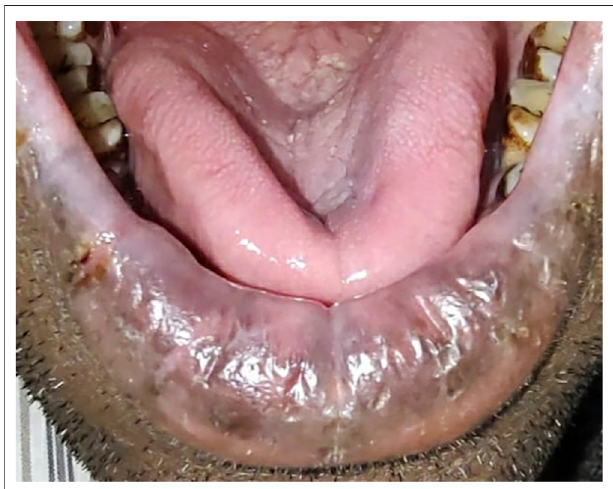
FIGURE 12 | Actinic cheilitis a typically presentation at lower